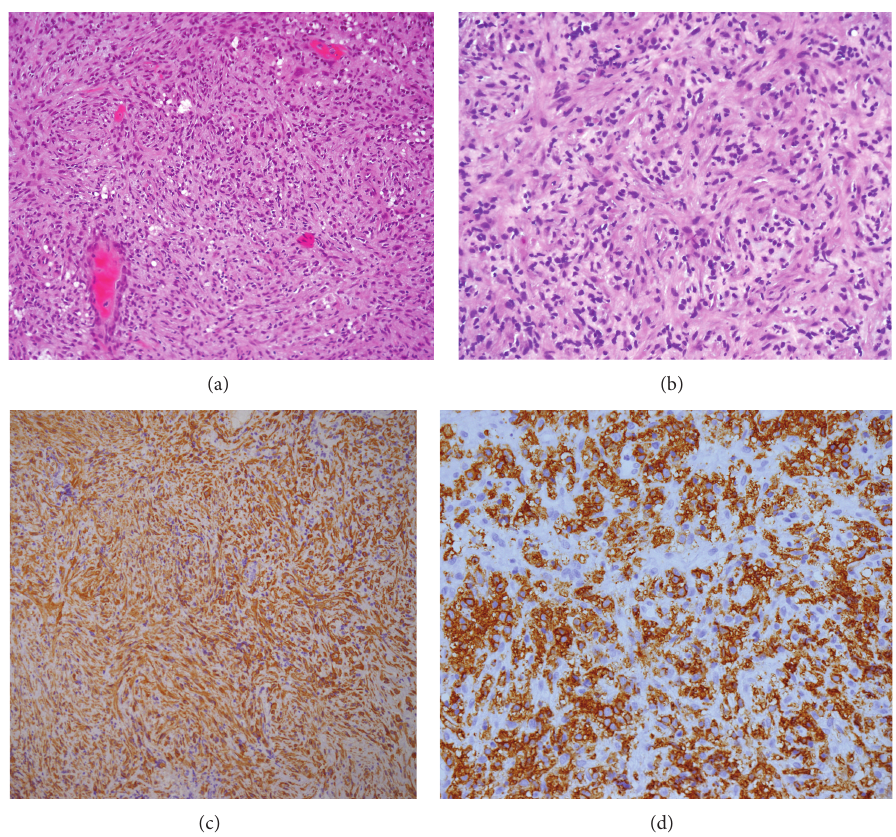
Figure 2: (a) HES × 10: a dense proliferation of spindle cells, partly with an epithelioid aspect, arranged in well-organized fascicles suspended in a myxoid background and admixed with many inflammatory cells, mostly lymphocytes, plasma cells, eosinophils, and rare mast cells. (b) HES × 20: spindle cells present with few atypical features: prominent nucleolus, anisokaryosis, and modest mitotic activity. (c) immunostaining with smooth muscle actin (SMA): spindle cells present a cytoplasmic and diffuse positivity with SMA. (d) immunostaining with CD45 (antipanleukocytes) exhibits the significant lymphoplasmacytic population. FISH analysis was performed: no rearrangement for ALK-1 gene was